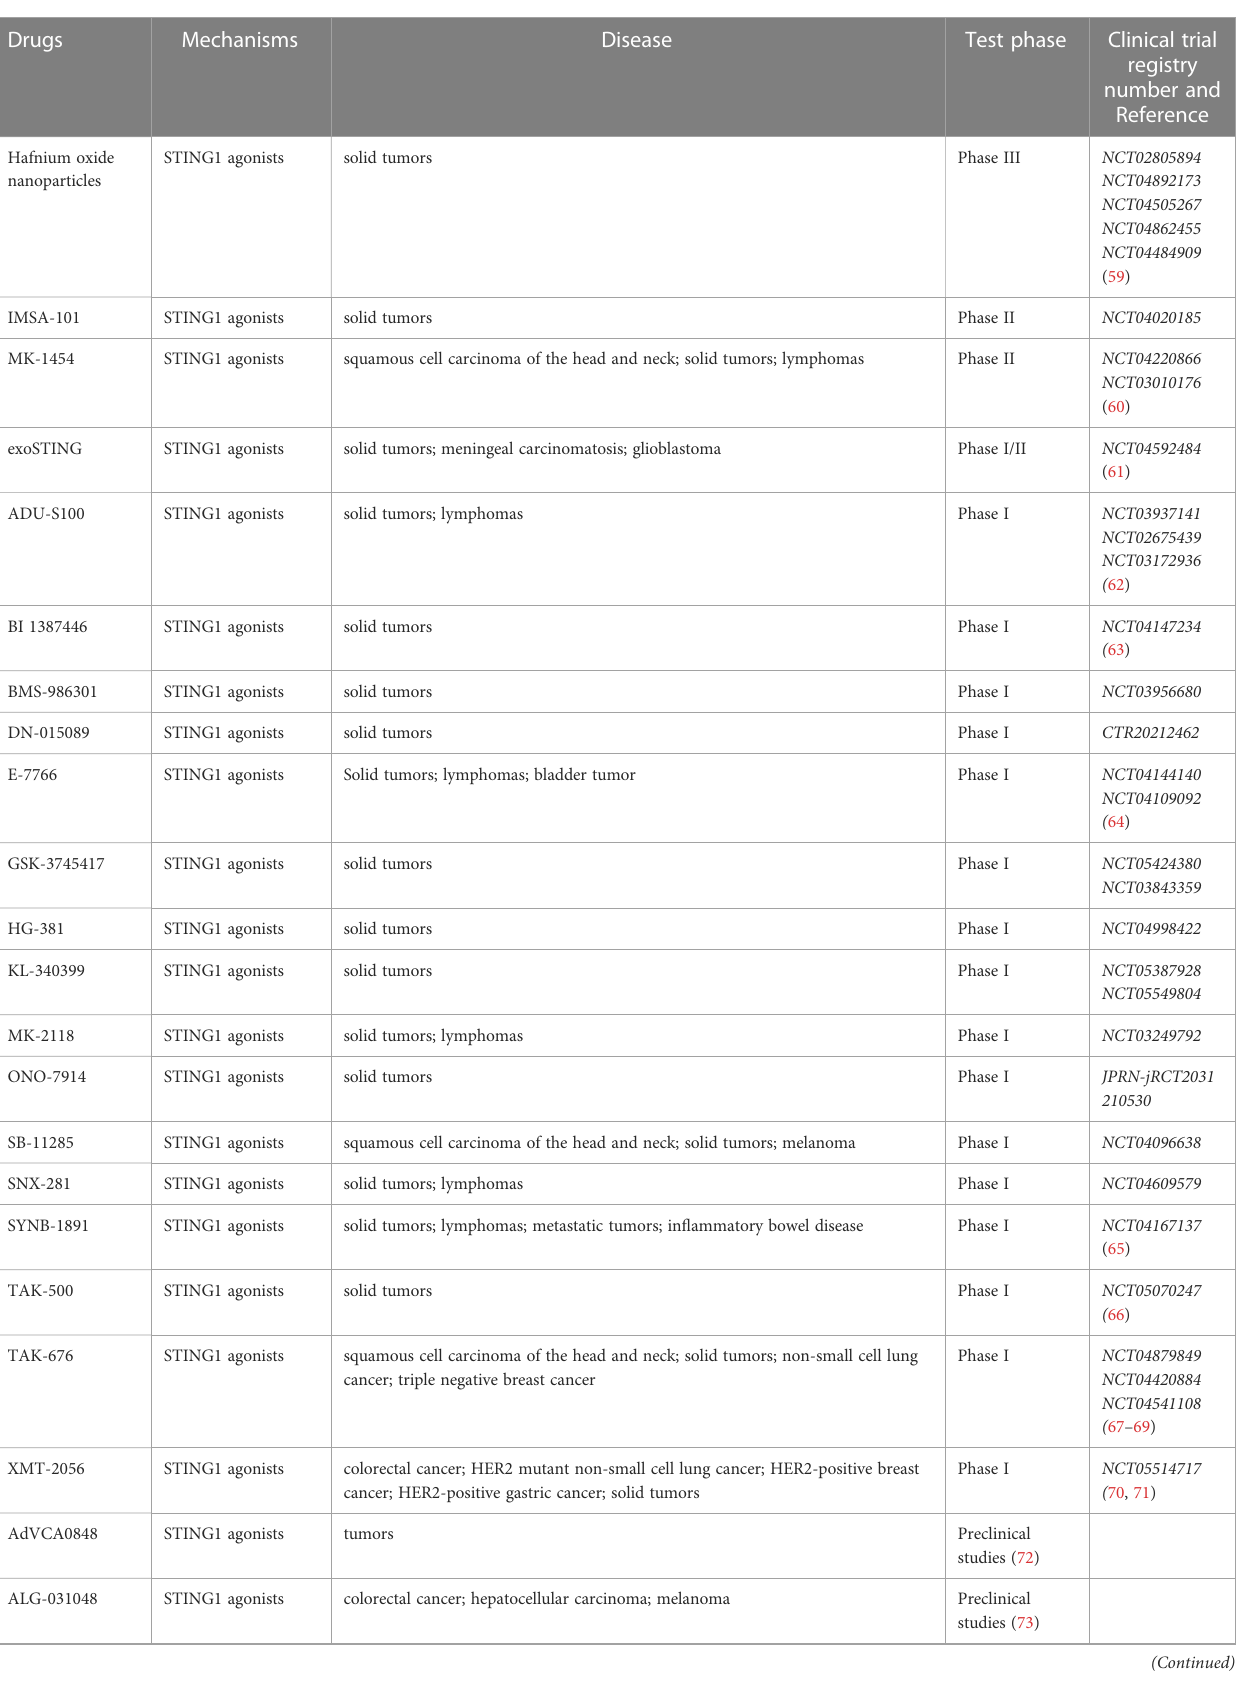
TABLE 1 STING agonists that have been included in clinical studies or preclinical